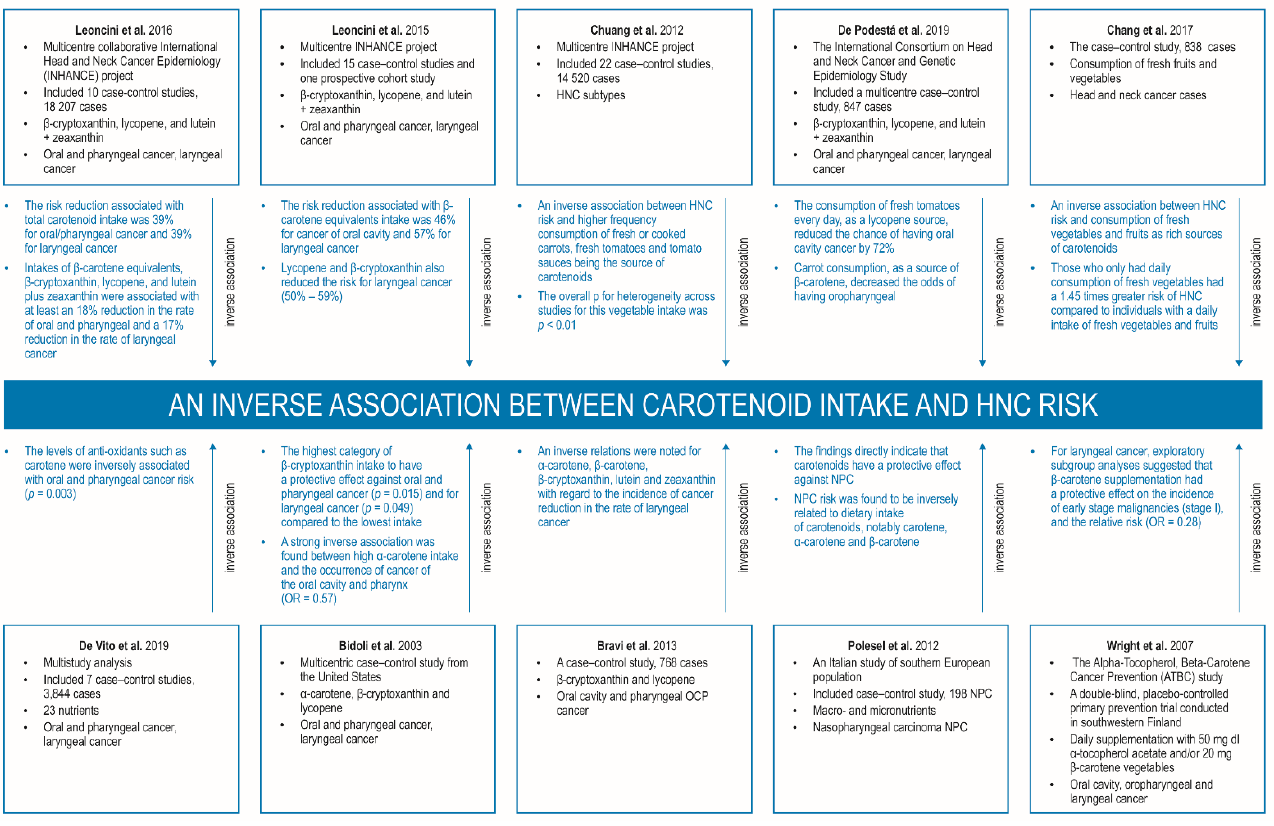
Figure 4. The representative scientific publications confirming an inverse association between ca- rotenoid intake and HNC risk [15–17,19,180,182,183,185–187]. carotenoid intake and HNC risk